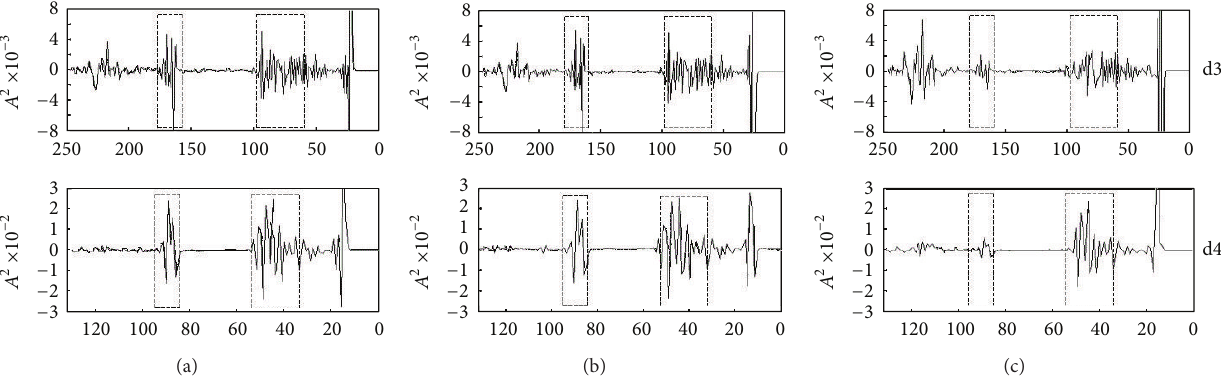
Figure 4: Division of feature region of high frequency components after discrete wavelet multiresolution decomposition. (a) Normal tissues; (b) early carcinoma tissues; (c) advanced carcinoma tissues.